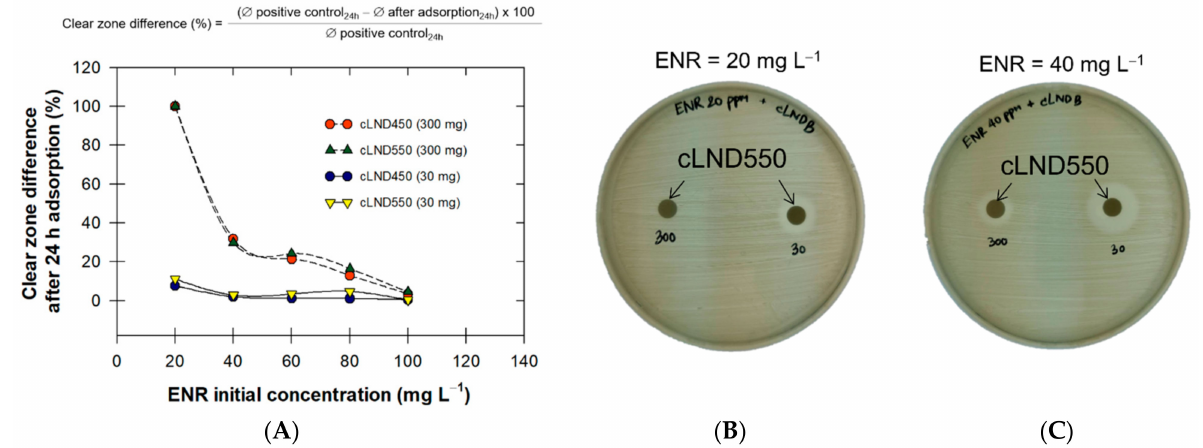
Figure 9. Changes in the clear zone after day 3 (C ∆ -3d ) of Staphylococcus aureus ATCC 25923 following ENR adsorption onto